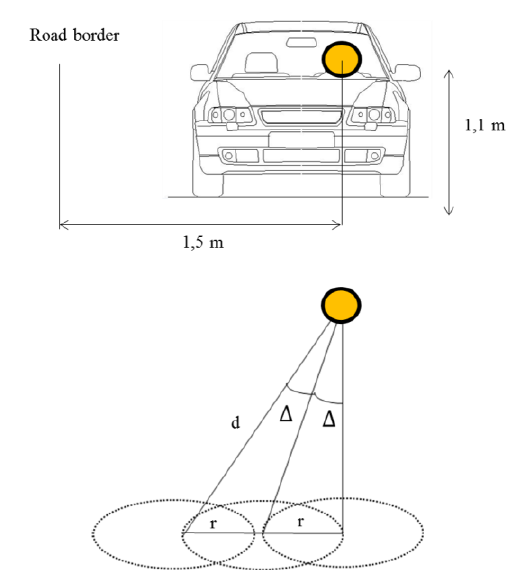
LOS rotation is carried out by varying a rotation angle  in the horizontal plane as the algorithm detects an occlusion (Figure 2).